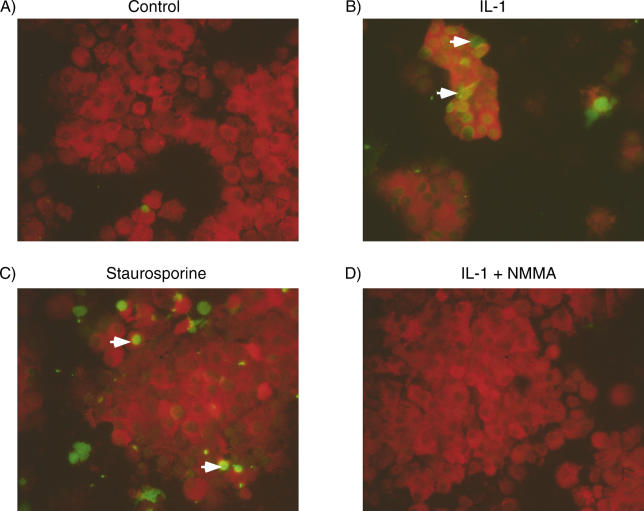
IL-1 Stimulates Islet Cell DNA Damage in a Nitric Oxide-Dependent MannerTreatment of rat islet cells for 24 h with IL-1 resulted in DNA damage as determined by TUNEL staining, and ∼95% of this damage occurred in insulin-containing cells (red fluorescence) (B). Nitric oxide appears to mediate IL-1-induced DNA damage, as it was attenuated by the NOS inhibitor NMMA (2 mM) (D). The apoptosis inducer staurosporine (1 μM) also stimulated DNA damage in both insulin containing and non-insulin containing cells (C). Less than 10% of control, untreated islet cells were TUNEL-positive (A). Results are representative of three independent experiments.